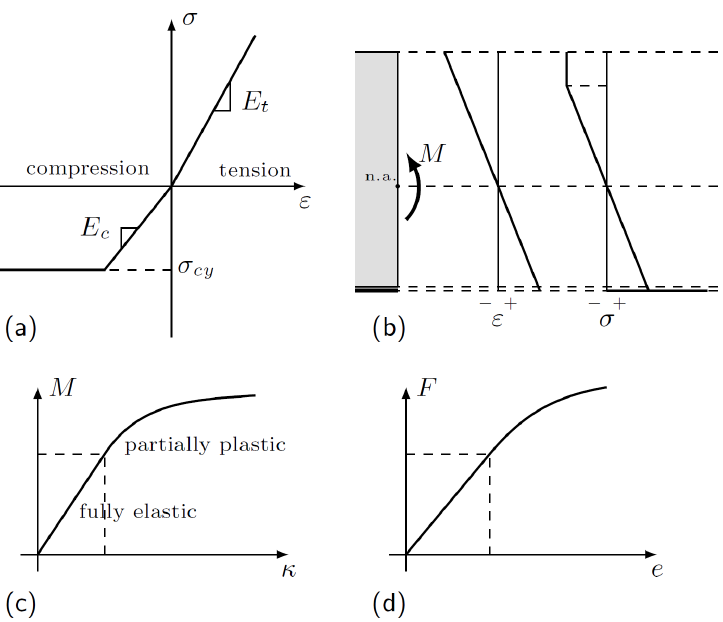
Figure 3. Constitutive modelling of timber cross-section. ( a ) Wood stress–strain relationship: elastic in tension, elastic–plastic in compression. ( b ) Strain and stress fields in the timber–CFRP composite cross-section. ( c ) Curvature–moment relationship based on the applied constitutive model and cross- section. ( d ) Simulated load–deflection curve based on the beam configuration and constitutive